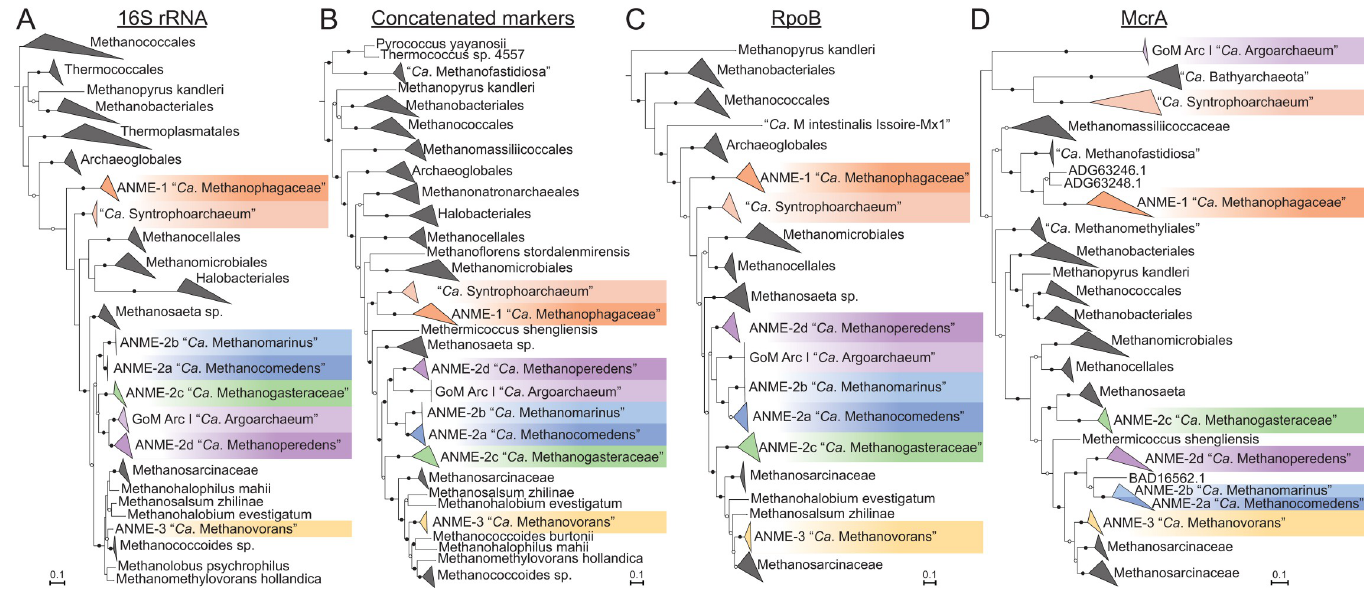
Fig 1. Phylogeny of ANME and related archaea. Phylogenetic trees constructed from ANME genomes, sequences of closely related archaea, and a selection of sequences derived from clone libraries demonstrate the relationship between ANME and methanogens of the Halobacterota . ( A ) Phylogenetic tree built with 16S rRNA gene sequences, root leads to sequence from Sulfolobus solfataricus p2. ( B ) Phylogenomic tree built with concatenated marker set 4 (see S1 Table for list), root also to S . solfataricus p2. ( C ) Phylogenetic tree built with protein sequence of RpoB, root leads to sequences from “ Ca . Methanomethyliales” and “ Ca . Bathyarchaeota.” ( D ) Phylogenetic tree of McrA protein sequences. Note the divergence of proposed alkane oxidizing McrA genes in “ Ca . Syntrophoarchaeum,” “ Ca . Bathyarchaeota,” and “ Ca . Argoarchaeum.” Branch support values of 100% are labeled with closed circles, > 50% with open circles. Tree scales represent substitutions per site. Tree construction parameters are found in the Materials and methods section. For tree files and alignments, see S1 Data . Detailed tree figures are presented in S2–S5 Figs . ANME, anaerobic methanotrophic; McrA, methyl-coenzyme M reductase subunit A; RpoB, RNA polymerase subunit beta; 16S rRNA, small subunit ribosomal RNA.